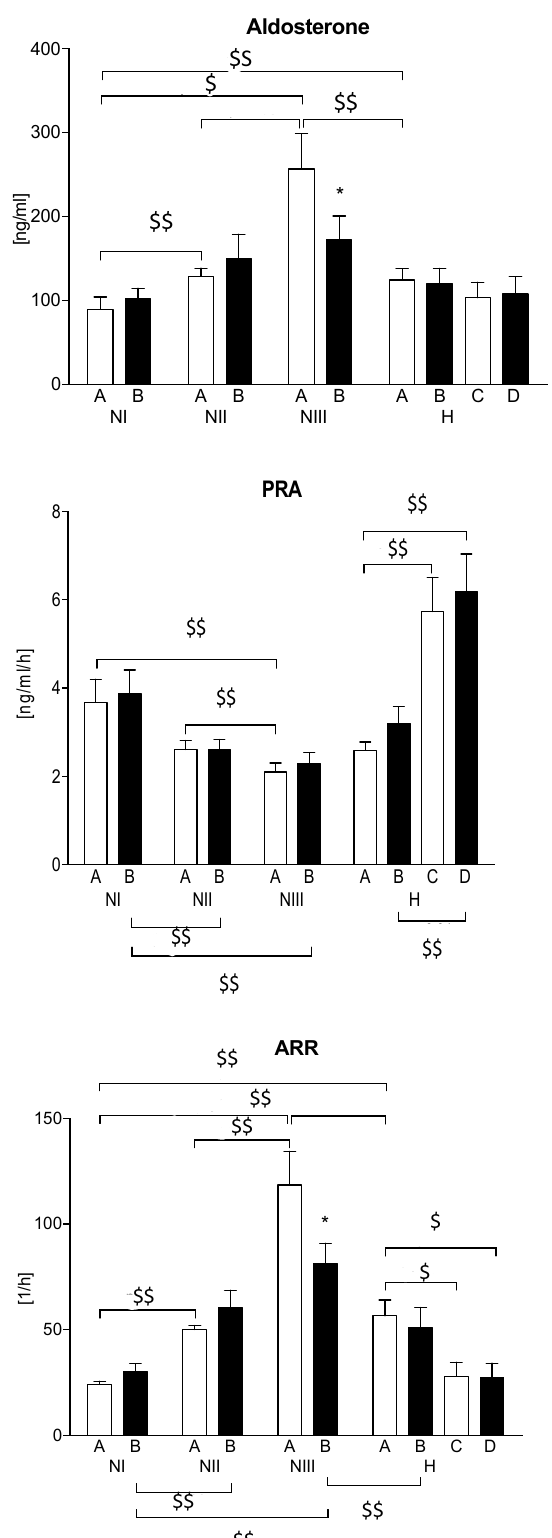
Figure 4. Assessment of the renin–angiotensin–aldosterone system. A—baseline; B—after ASA; C— after valsartan; D—after valsartan and ASA; PRA—plasma renin activity; ARR—aldosterone-to-renin ratio; * p < 0.05 A vs. B; $ and $$—p < 0.05 and p < 0.001 vs. another subgroup at the same step of study protocol, respectively.